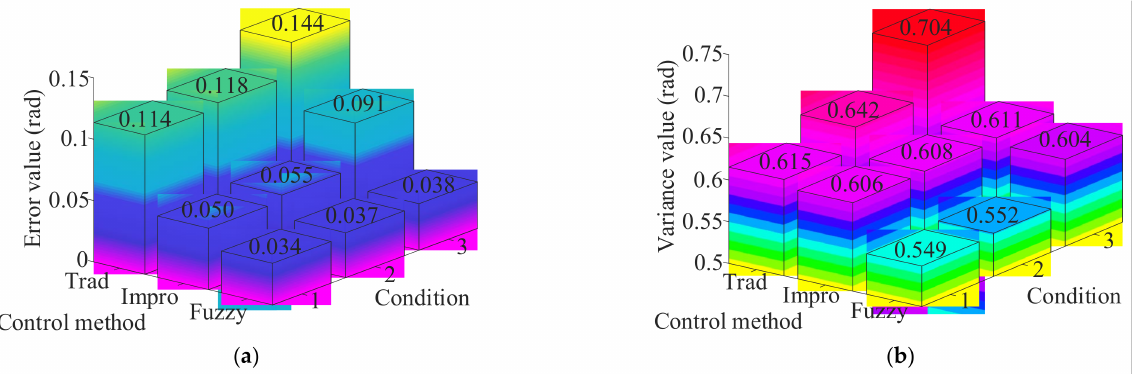
Figure 9. Error statistical index: ( a ) absolute error statistics index; ( b ) statistical index of